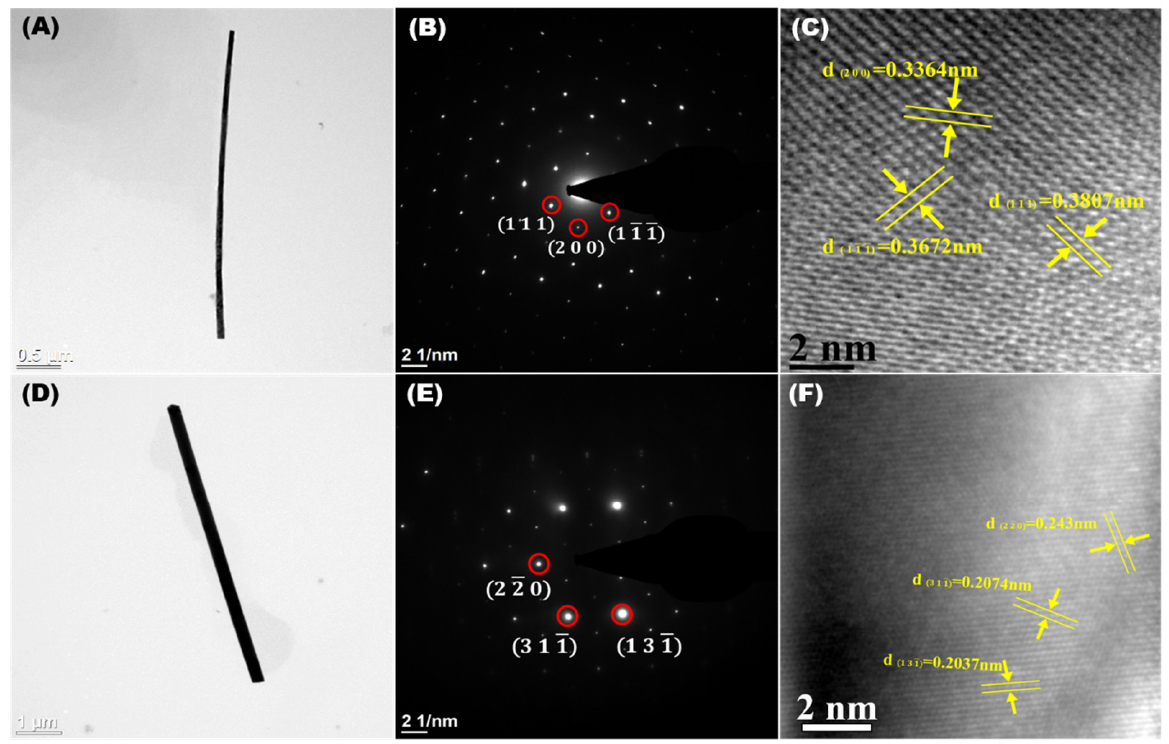
Figure 4. TEM image ( A ), selected area diffraction ( B ), and the HR-TEM ( C ) of a single InSb nanowire fabricated using O-AAO. TEM image ( D ), selected area diffraction ( E ), and the HR-TEM ( F ) of a single InSb nanowire fabricated using P-AAO.